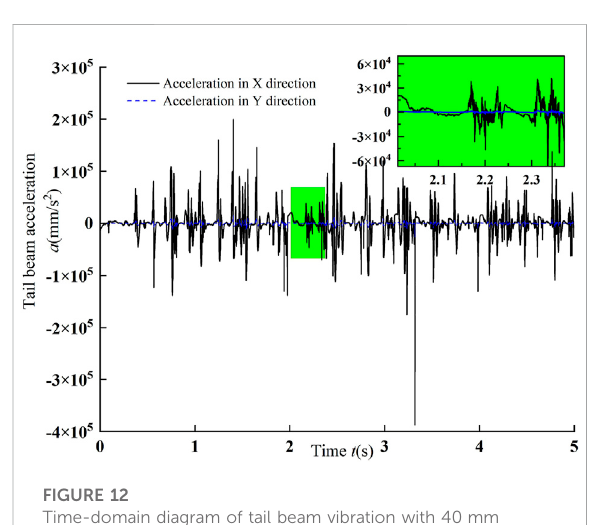
FIGURE 12 Time-domain diagram of tail beam vibration with 40 mm particle size.